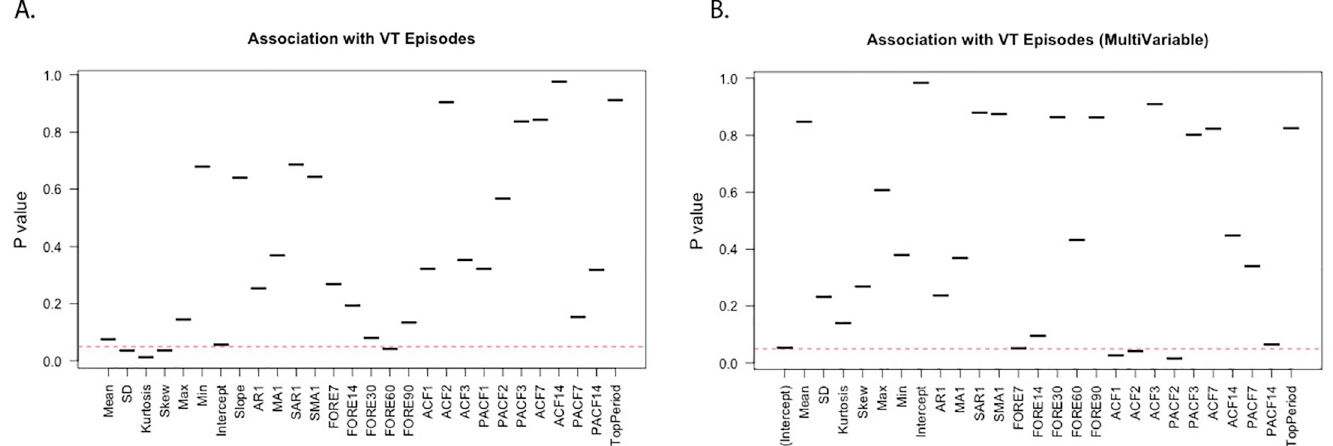
Fig 2. A. Univariate association with VT episodes (t-test). B. Multivariable logistic regression p-values for association with VT episodes . Dashed red line: p = 0.05.